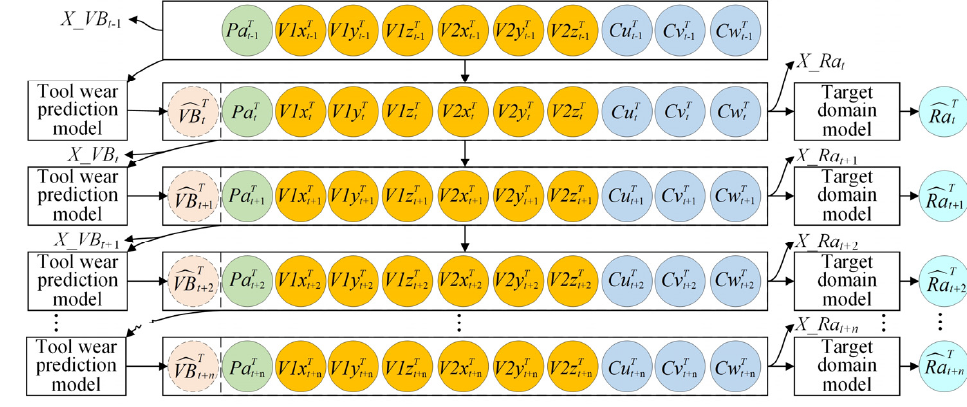
Figure 7. Surface roughness prediction integrating tool wear.